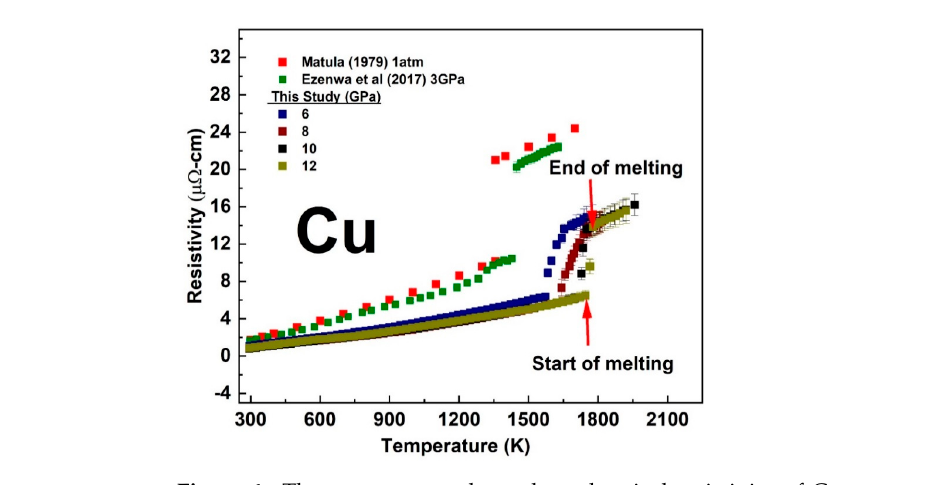
Figure 4. The temperature dependent electrical resistivity of Cu measured at fixed pressure in comparison with previous studies [10,19].